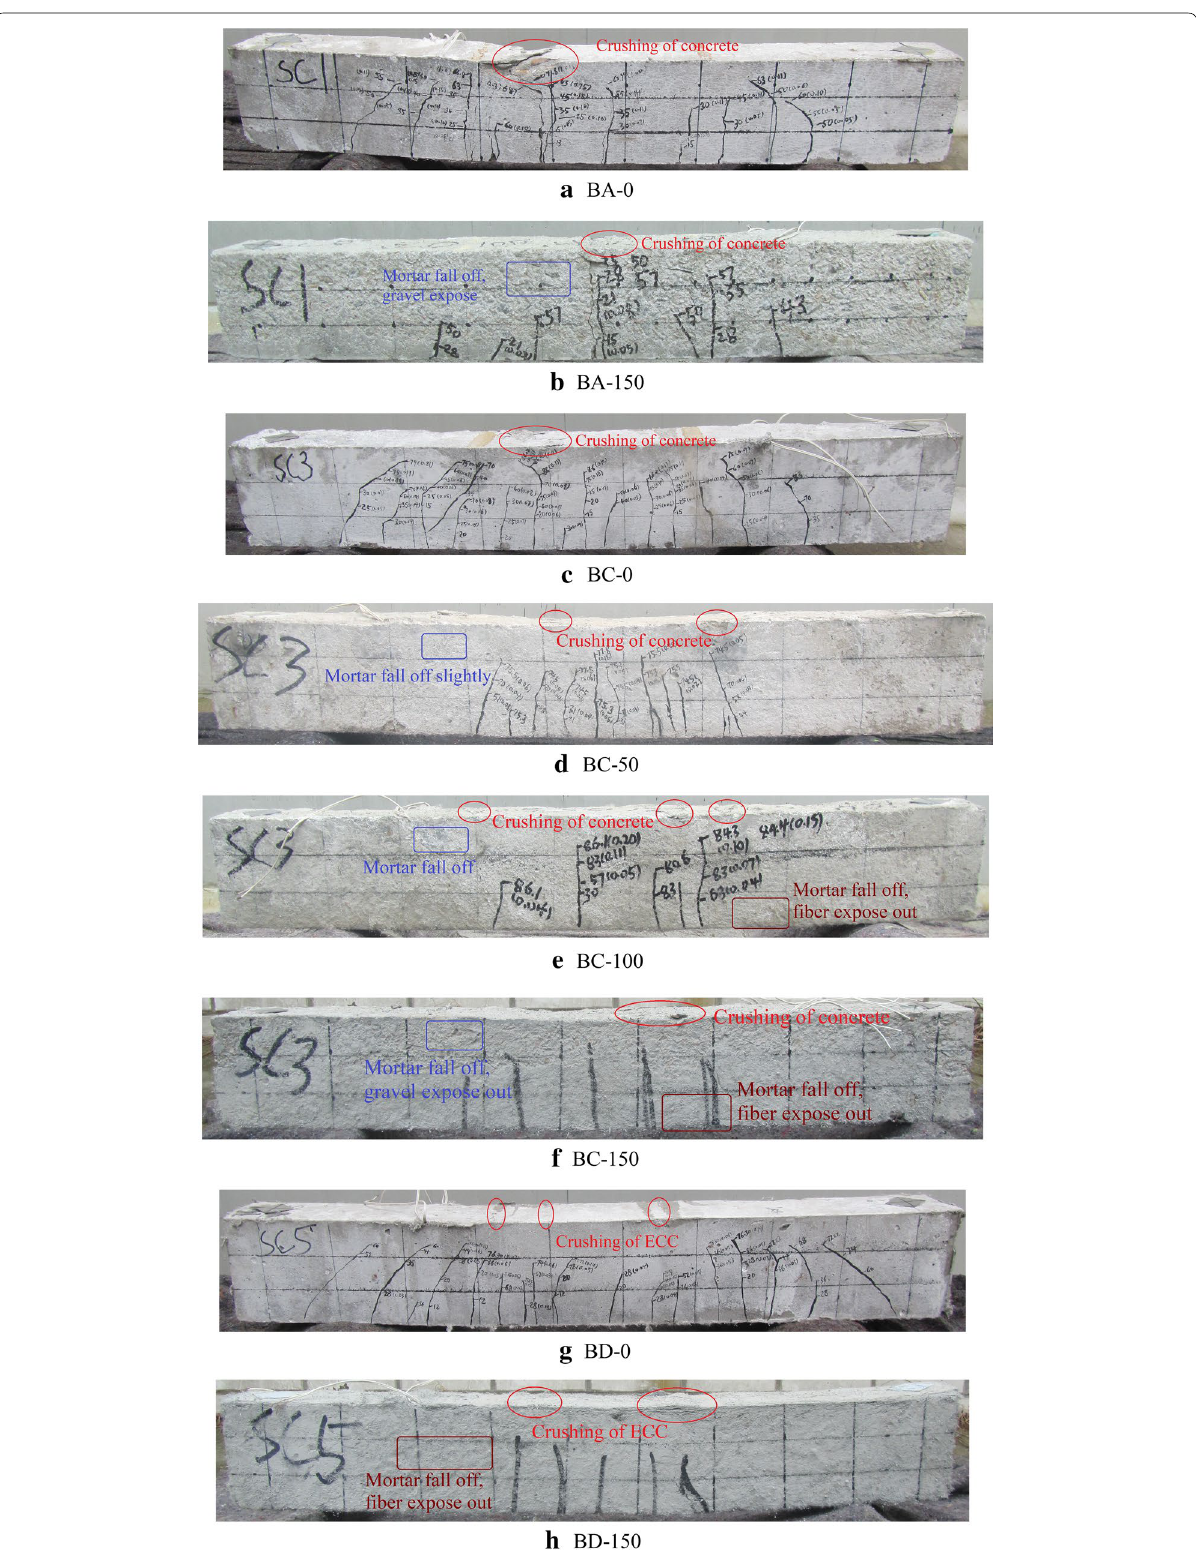
Fig. 8 Failure modes of selected test